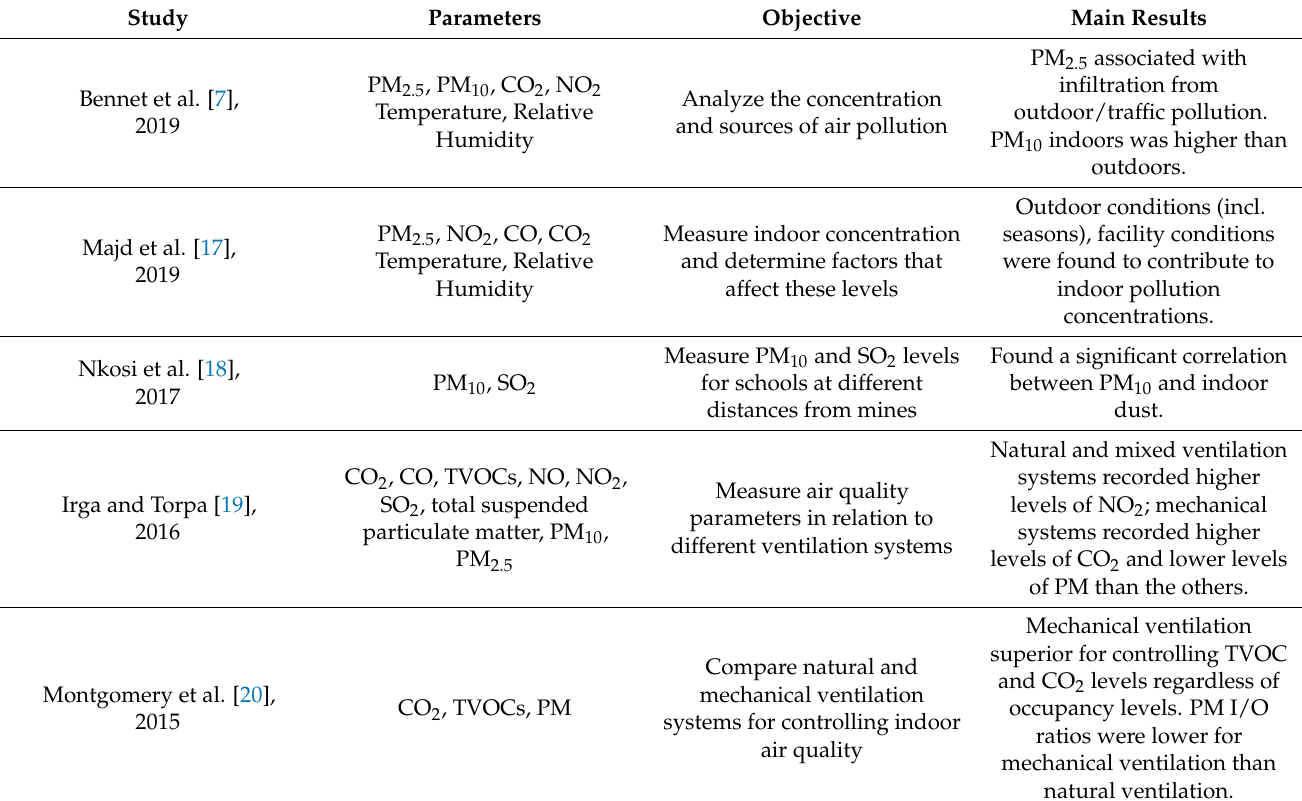
Table 1. Recent air quality studies in the